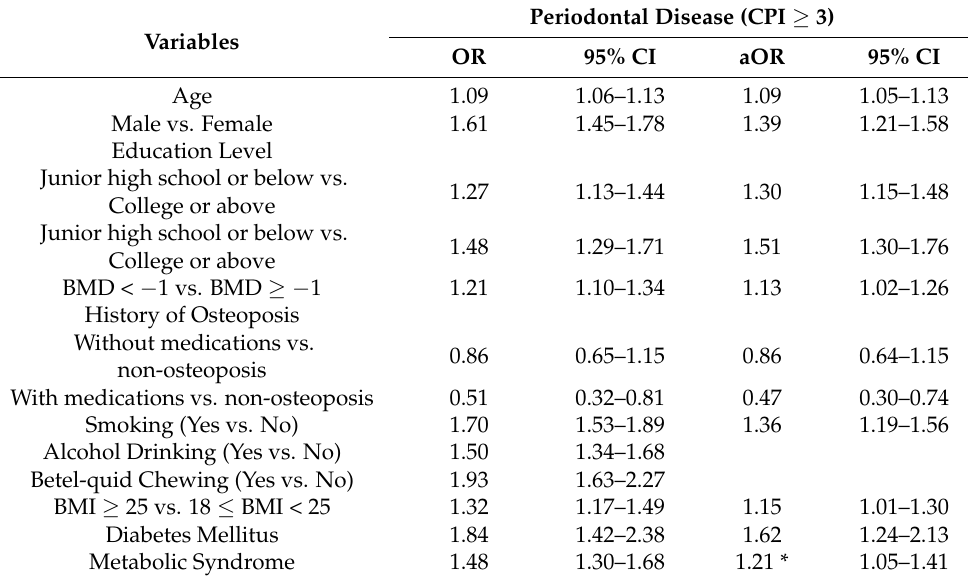
Table 3. The association between low bone mass, other factors, and periodontal disease